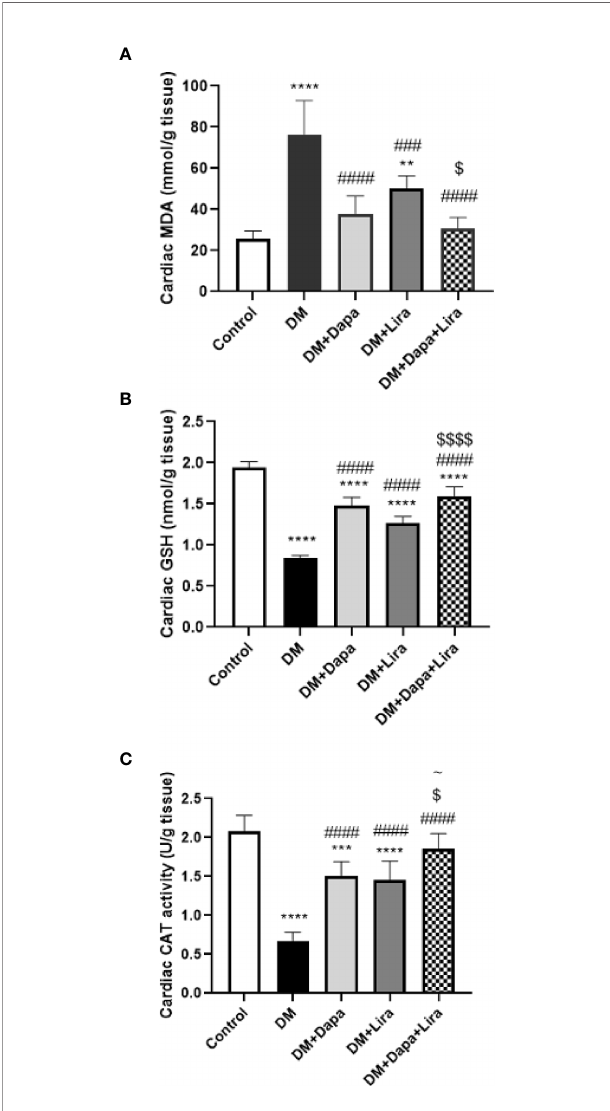
FIGURE 3 | Effect of dapagli fl ozin (Dapa) and liraglutide (Lira) or their combination on oxidative stress biomarkers in rat heart tissues: (A) tissue malondialdehyde (MDA), (B) tissue reduced glutathione (GSH), and (C) tissue catalase activity (CAT). Data are represented as mean ± SE, n = 6. **signi fi cance incomparisonwith control group at p < 0.01, *** at p < 0.001, **** at p < 0.0001, ### signi fi cance in comparison with diabetic group at p < 0.001, #### at p < 0.0001, ~ signi fi cance in comparison with DM+Dapaat p < 0.05, $ signi fi cance in comparison with DM+Lira group at p < 0.05, $$$$ at p <